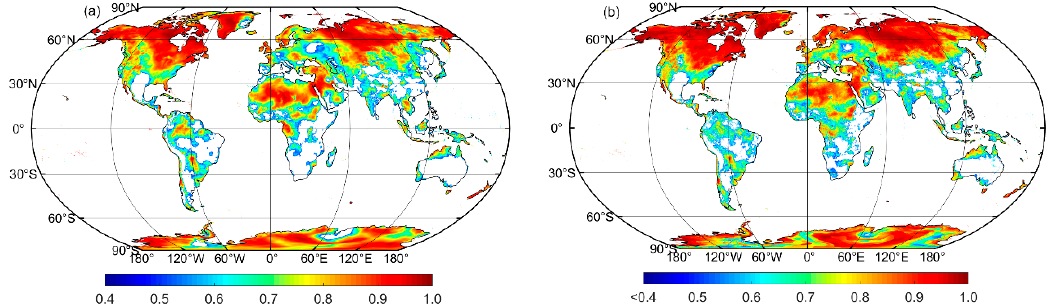
Figure 13. The spatial distribution of the correlation coefficient between the generated L d estimation and ( a ) ERA5 2-m air temperature and ( b ) water vapor pressure from 2003 to 2018. Only significant pixels where p values are less than 0.05 appeared.